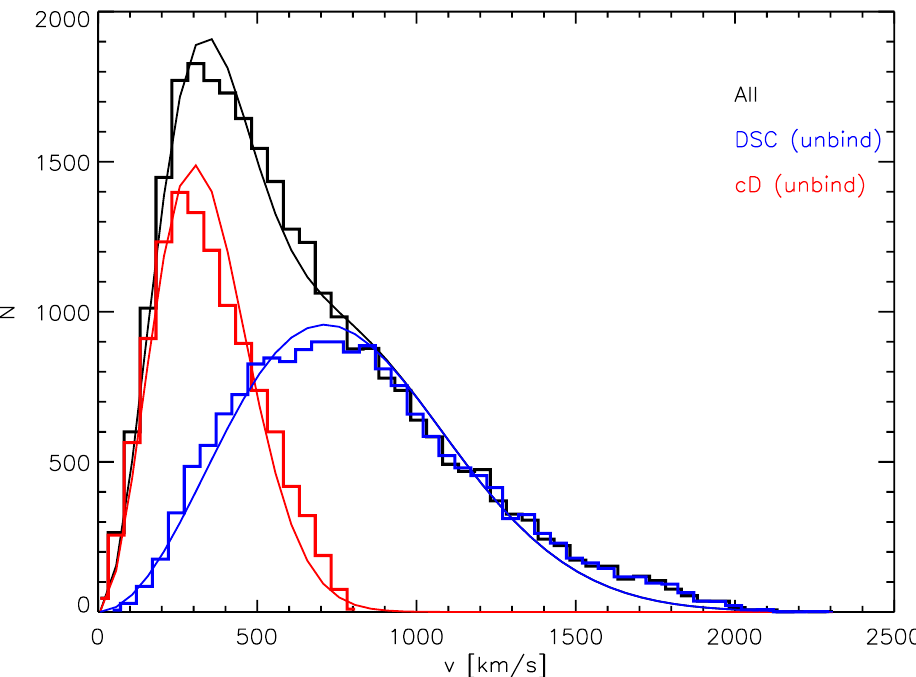
Figure 4. Total velocity distribution of BCG + ICL is marked with a black histogram and its double Maxwellian fit with a grey line. The red and the blue histograms show the velocity distributions of the BCG (called cD in the plot) and ICL (called DSC, diffuse light component, in the plot) stars, and the corresponding red and blue lines are the two separated Maxwellian distributions. Credit: Dolag et al.